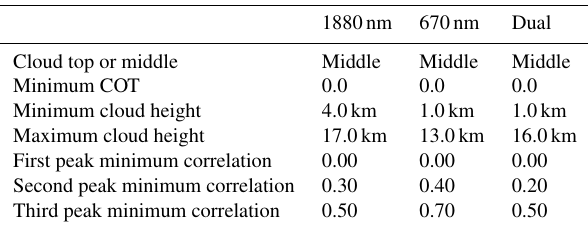
Table 4. Filters used for the optimal performance